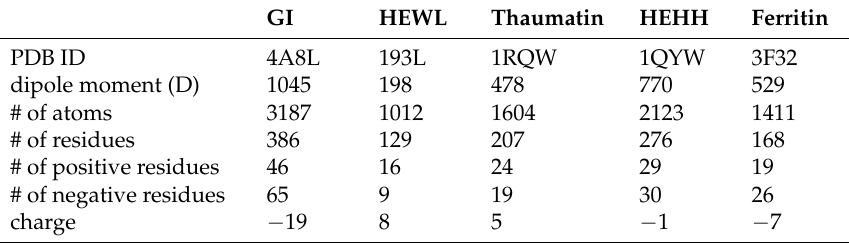
Figure 4. Top panel : Glucose Isomerase from Streptomyces rubiginosus, nearly 49% of the secondary structure is helical (192 residues in 20 helices) and only 10% is arranged in beta sheets (39 residues in 17 strands): ( a ) crystal structure (PDB ID 4A8L); ( b ) monomer showing the electric dipole moment vector (http://dipole.weizmann.ac.il); and ( c ) surface charge (Coot: http://lmb.bioch.ox.ac.uk/coot/). Bottom panel : Hen Egg White Lysozyme (HEWL) (PDB ID 193L) ( d ) monomer showing electric dipole moment and ( e ) surface charge; and Thaumatin (PDB ID 1RQW) ( f ) monomer showing electric dipole moment and ( g ) surface charge. Electric dipole moment vector was determined online through http://dipole.weizmann.ac.il and surface charge by Coot: http://lmb.bioch.ox.ac.uk/coot/. Table 1. Electric dipole moment computed for several macromolecules commonly crystallized in the presence of electric fields, DC or AC.